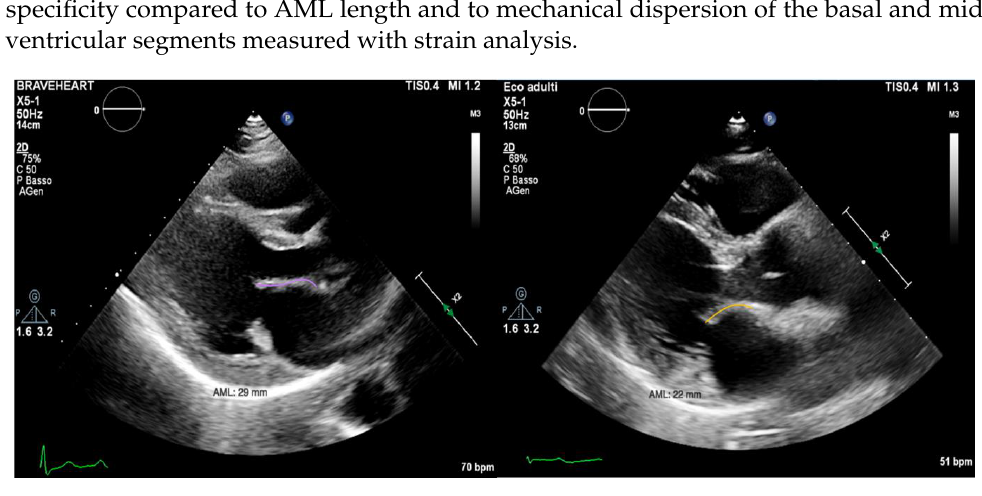
Table 5. Sensitivity and specificity of the best cut-off values identified for each predictor.